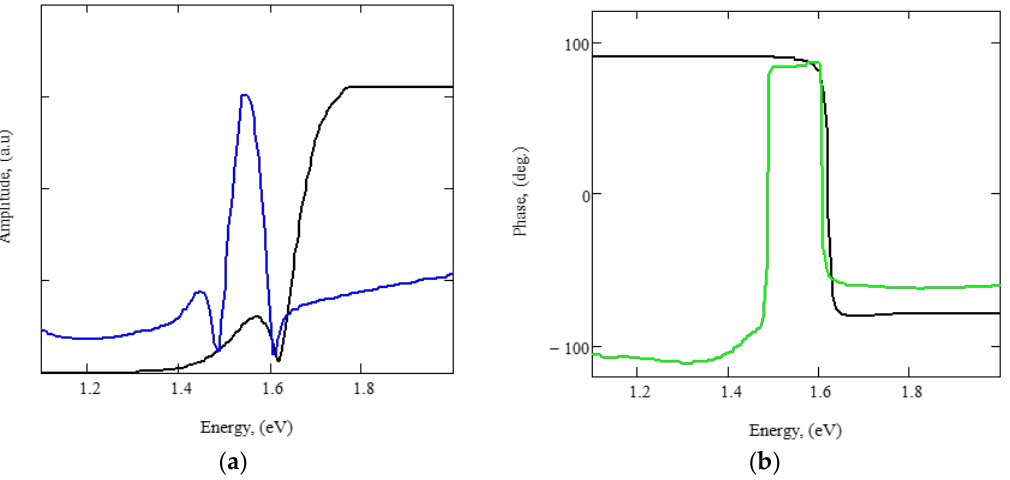
Figure 2. ( a ) Experimental amplitude (blue) and ( b ) phase (green) spectra of Cd 0.95 Be 0.05 Te in the rear configuration at the frequency modulation of 126 Hz. The solid black lines simulate the ideal crys- tal ’ s theoretical amplitude and phase